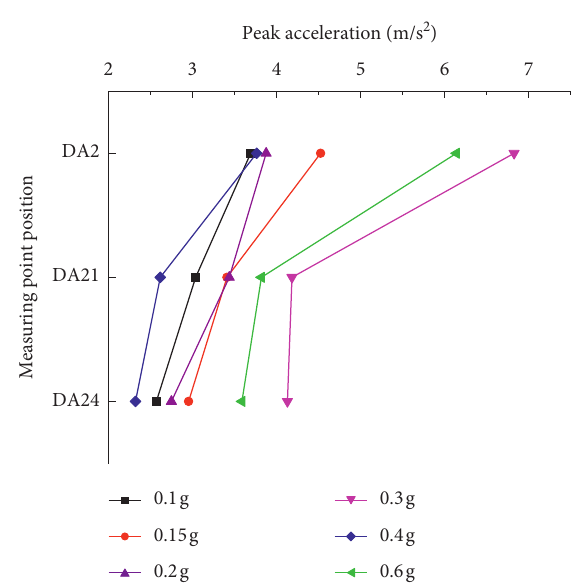
Figure 12: Peak acceleration of bridge pile on riverside at different measuring